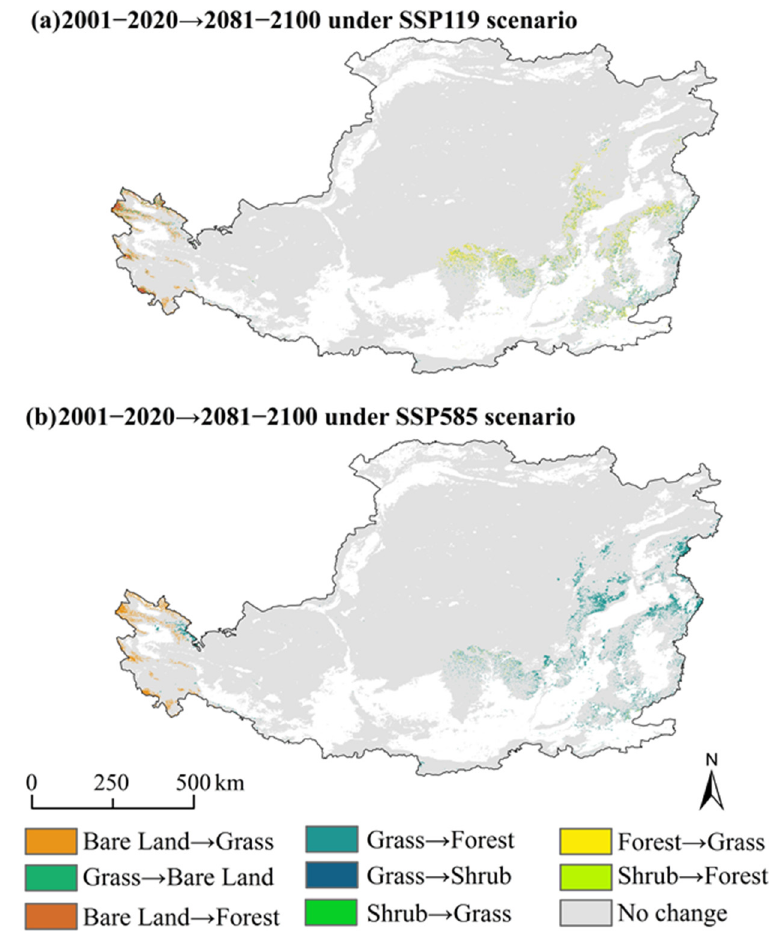
Figure 3. Conversions of vegetation types from 2001–2020 to 2081–2100. Table 2. Proportion (%) of vegetation type conversion area in the total area of the Loess Plateau